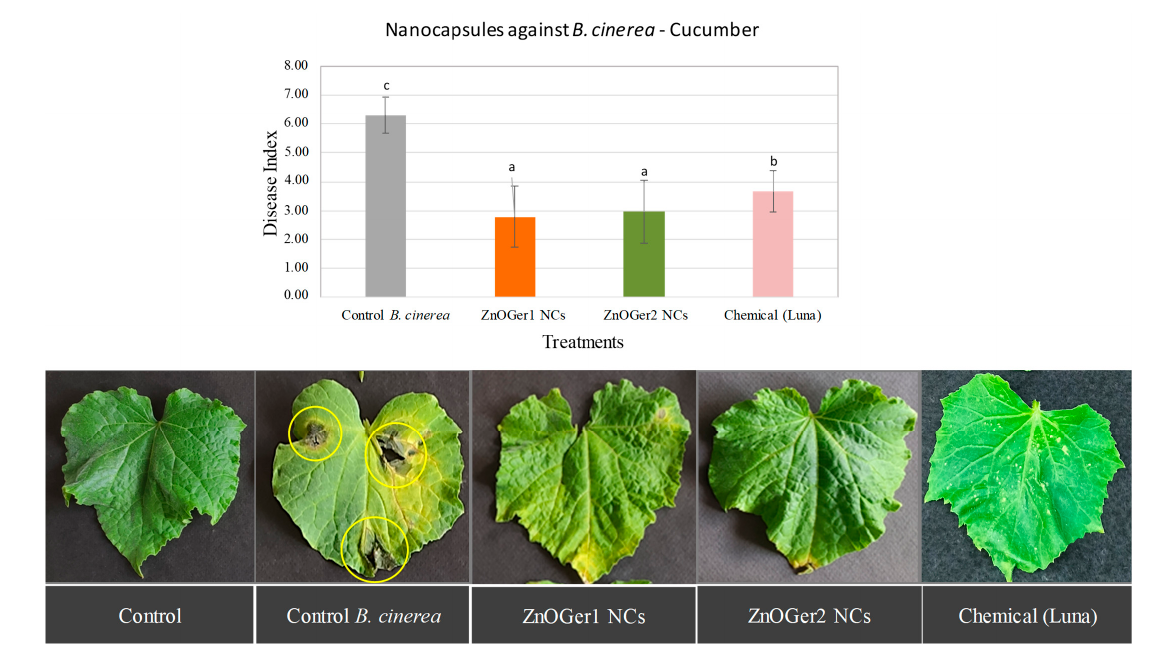
Figure 6. Effect of ZnOGer1 NCs and ZnOGer2 NCs on the severity of disease caused by B. cinerea on cucumber leaves in pots under controlled conditions. B. cinerea control plants were inoculated only with the pathogen (control B. cinerea ). The disease was assessed according to the disease index (DI) [9] after 96 h. The experiment was repeated three times. Different letters indicate significant differences according to Tukey’s test at p ≤ 0.05. Error bars represent standard deviation.